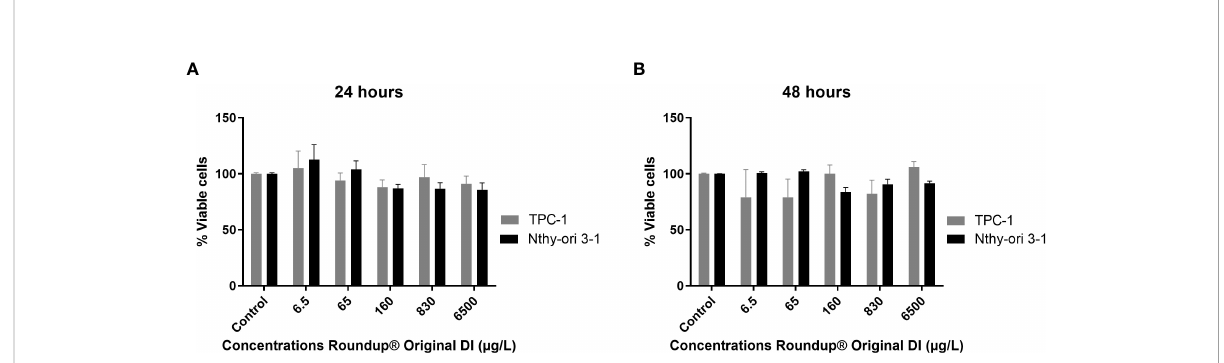
FIGURE 4 Comparison between the percentage of viable TPC-1 and Nthy-ori 3-1 cells at 24 h (A) and 48 h (B) of exposure to different concentrations of Roundup ® Original DI using the CCK-8 assay and presented as mean percentage of viable cells ± SE.